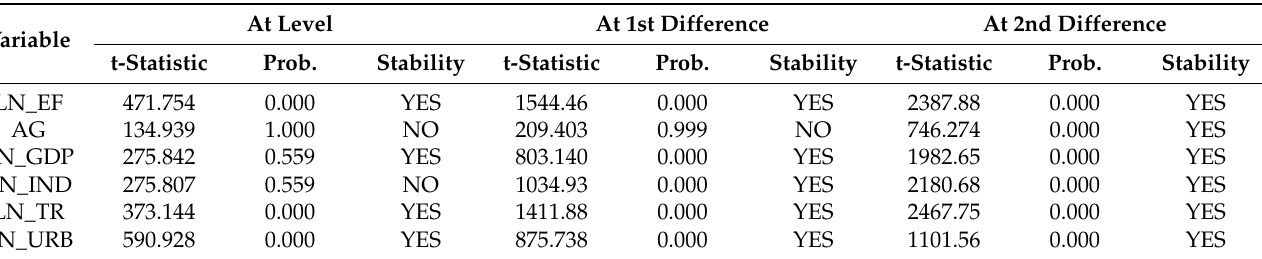
Table 4. Unit root test of panel